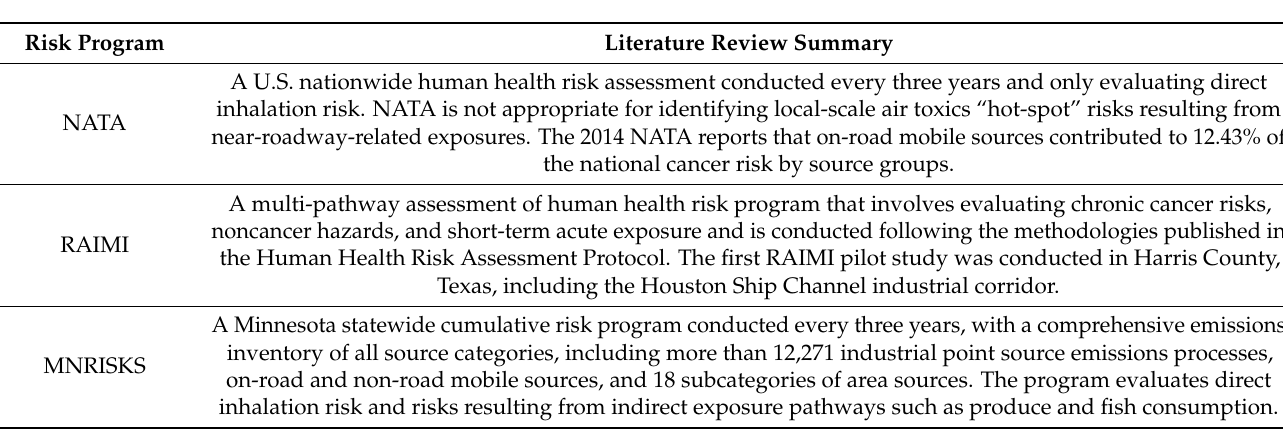
Table 1. Literature Review